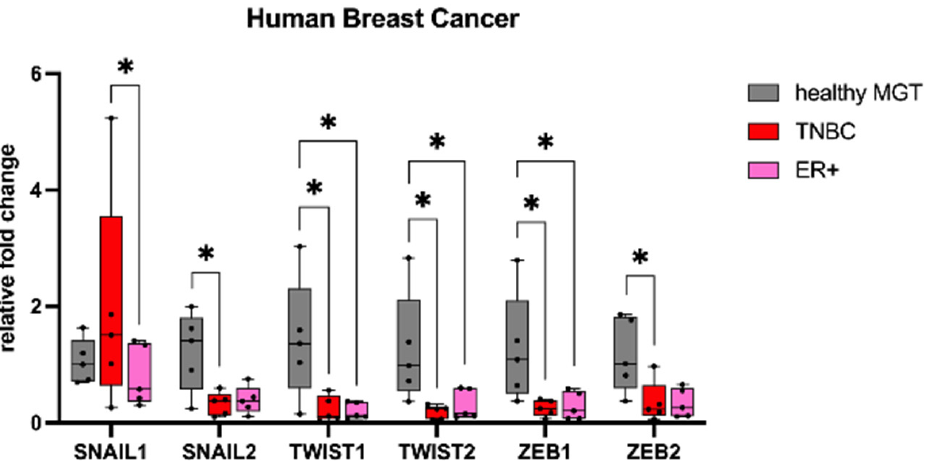
and TNBCs was significantly lower than in healthy MGTs ( p < 0.05). Additionally, TNBCs had a significantly lower mRNA expression of SNAIL2 and ZEB2 when compared with healthy MGTs ( p < 0.05).